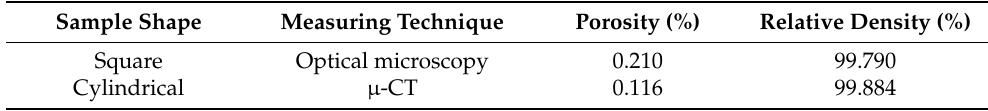
Table 5. Porosity and relative density of the as-built